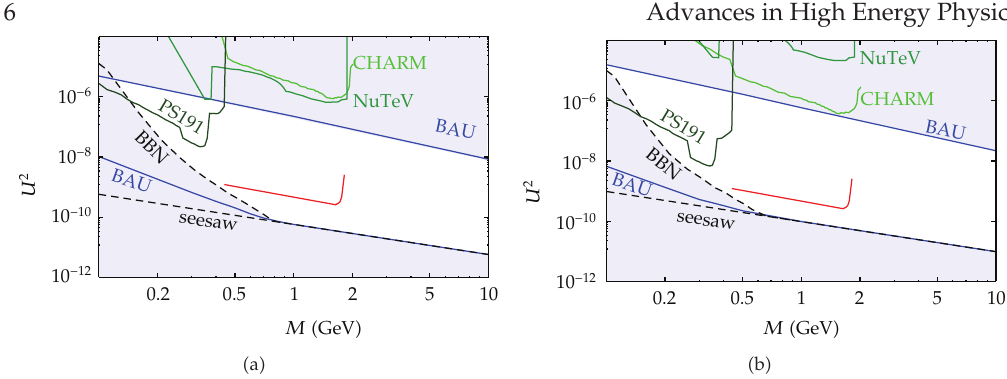
Figure 4: The allowed region of parameters of sterile neutrinos, responsible for neutrino oscillations (cid:2) region above the dotted “seesaw” line (cid:3) and for baryo/leptogenesis (cid:2) region between two black solid lines (cid:3) . Sterile neutrinos with the parameters in the shaded region to the left of the “BBN” line would spoil predictions of primordial nucleosynthesis. Accelerator experiments, searching for heavy neutral leptons exclude regions above green lines. (cid:2) a (cid:3) restrictions for normal hierarchy (cid:2) b (cid:3) inverted hierarchy. Adopted from (cid:4) 27 (cid:5) . The region above the red curve can be probed with a single section of the detector of length l || ∼ 100m, height 5m and width l ⊥ ∼ 5m, placed at a distance of about hundred meters, see the text for details.